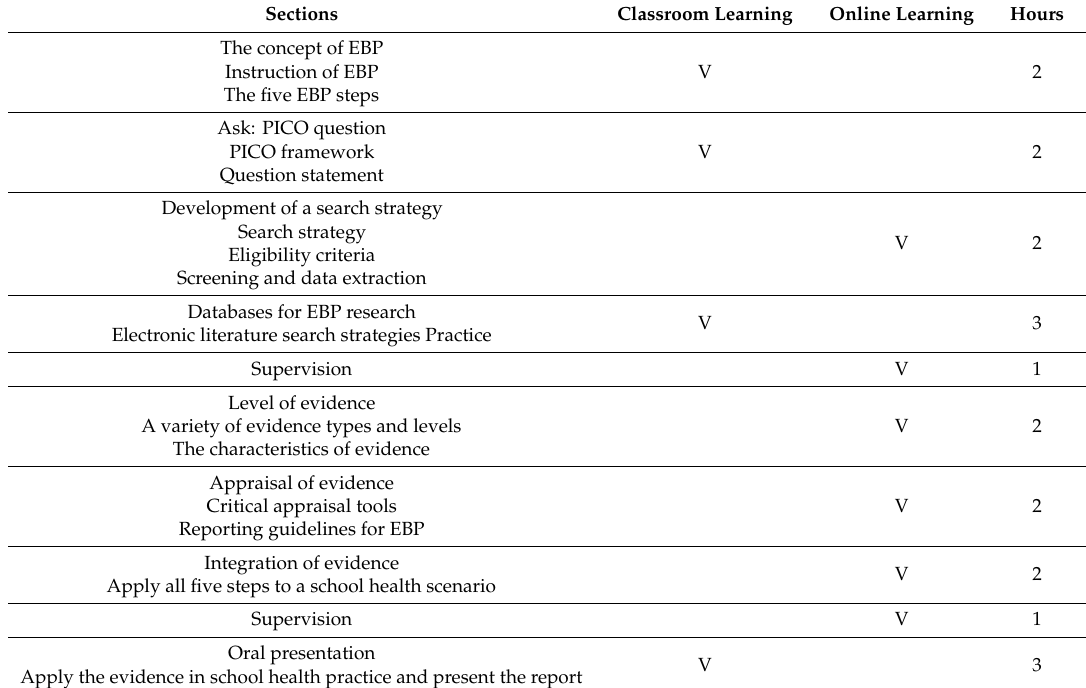
Table 1. Outline of the evidence-based practice (EBP) training